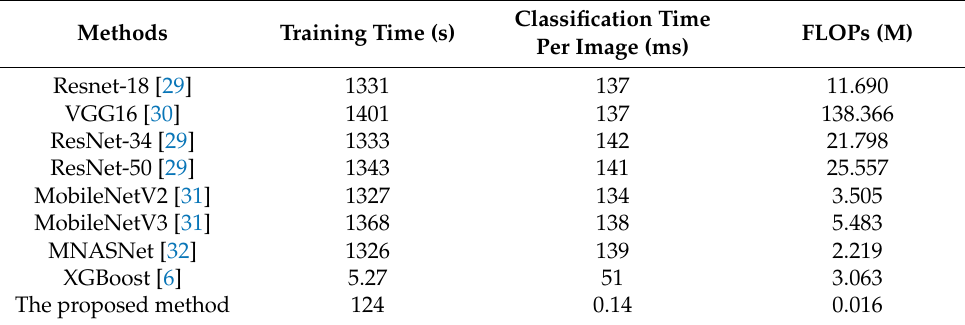
Table 6. The complexity of different